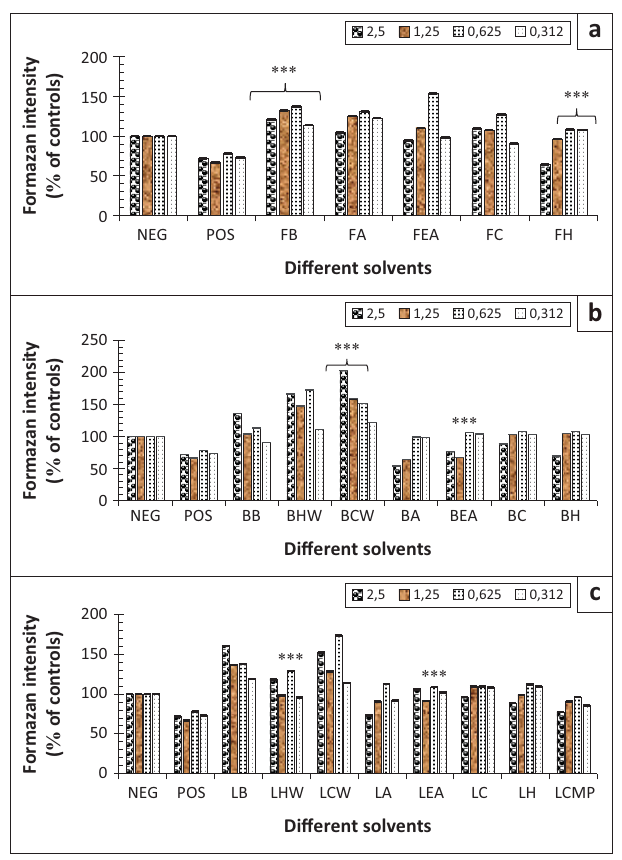
FIGURE 4: MTT assay on skeletal muscle (C2C12) cells treated with C. grandicalyx bark, leaves and fruits extracts for 24 h with H